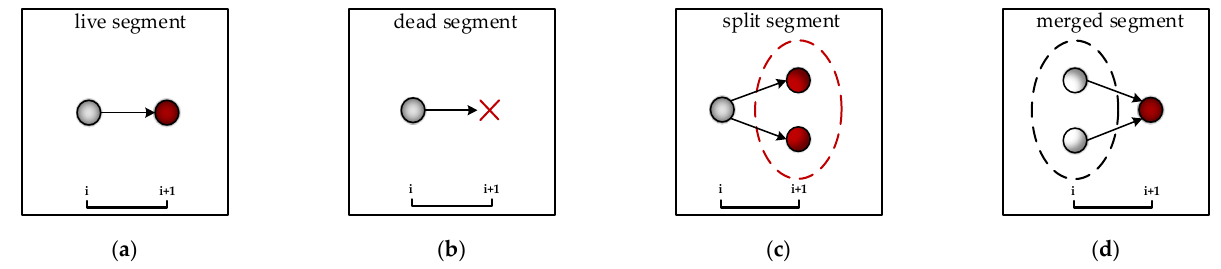
Figure 4. The four types of segments considered in this paper, where the eddies on day i and day i + 1 are expressed by the gray and red circles, respectively, while the common eddygroups on day i and day i + 1 are represented by the black dashed line and red dashed line, respectively: ( a ) live segment consisting of the eddies with live relationships in two adjacent time steps; ( b ) dead segment consisting of an eddy that is dead in the next time step; ( c ) split segment consisting of the eddies with split relationships in two adjacent time steps; ( d ) merged segment consisting of the eddies with merged relationships in two adjacent time steps.